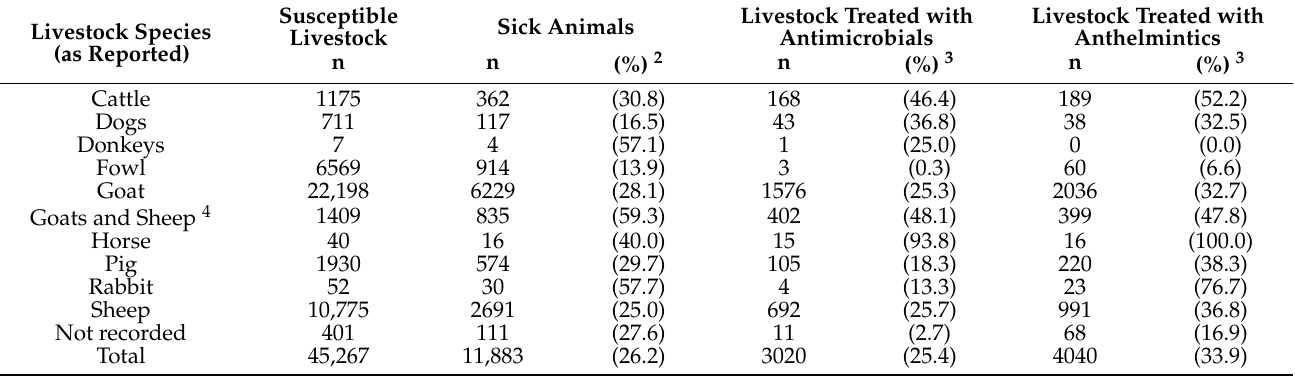
Table 2. Number of livestock treated with antimicrobials or anthelmintic drugs used by animal species in Sierra Leone, March–October 2021 1